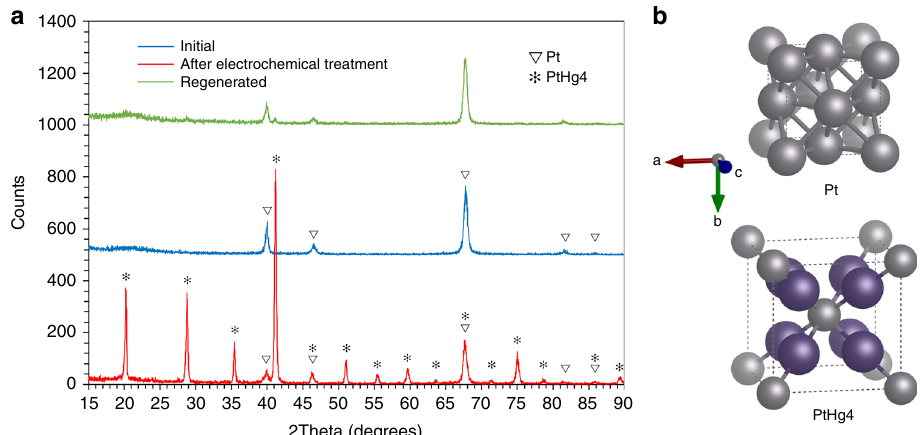
Fig. 2 X-ray Diffraction characterization of electrodes before and after electrochemical treatment, and after regeneration. a The XRD patterns of 100 nm platinum electrodes before (blue line) and after electrochemical treatment (red line), and after regeneration (green line). The number of counts on the x - axis has been offset for clarity (plus 500 and 1000 counts for the initial and regenerated electrodes, respectively). b Schematic illustrations of the unit cells for platinum and PtHg